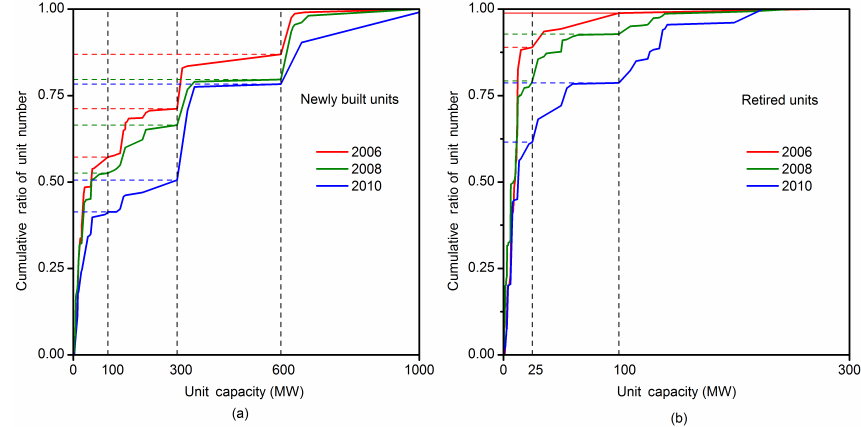
Figure 2. Cumulative ratio of unit number for (a) newly constructed and (b) retired electric-generating units for 2006, 2008, and 2010. The units are sorted according to ascending capacity along the x axis.